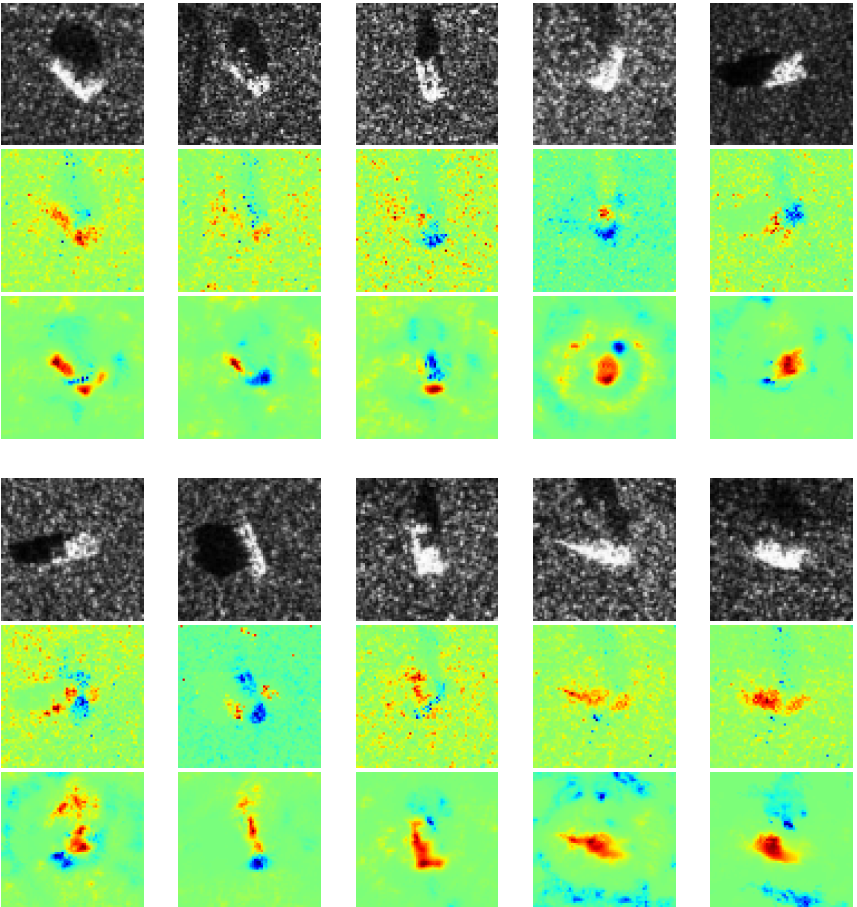
Figure 5. Comparison of common LRP and our method. The first and fourth row are the SAR images of ten classes: 2S1, BRDM_2, BTR_60, D7, SN_132, SN_9563, SN_C71, T62, ZIL131, and ZSU_23_4. The second and fifth row are corresponding heatmaps generated by common LRP. The third and sixth row are corresponding heatmaps generated by our